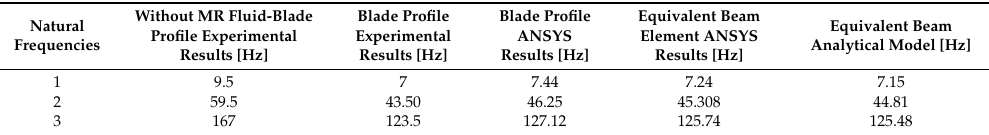
Table 1. Natural frequencies of the blade profile and equivalent beam.